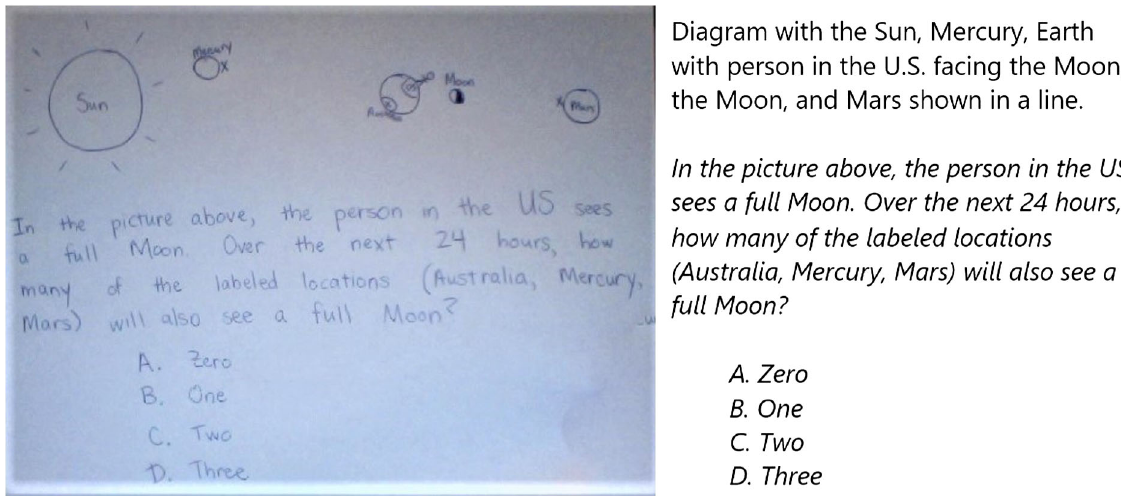
FIG. 2. Example A from the faculty-produced Think-Pair-Share questions. The original is reproduced on the left with a transcript on the right. Italicized portions indicate text of question prompt and answer